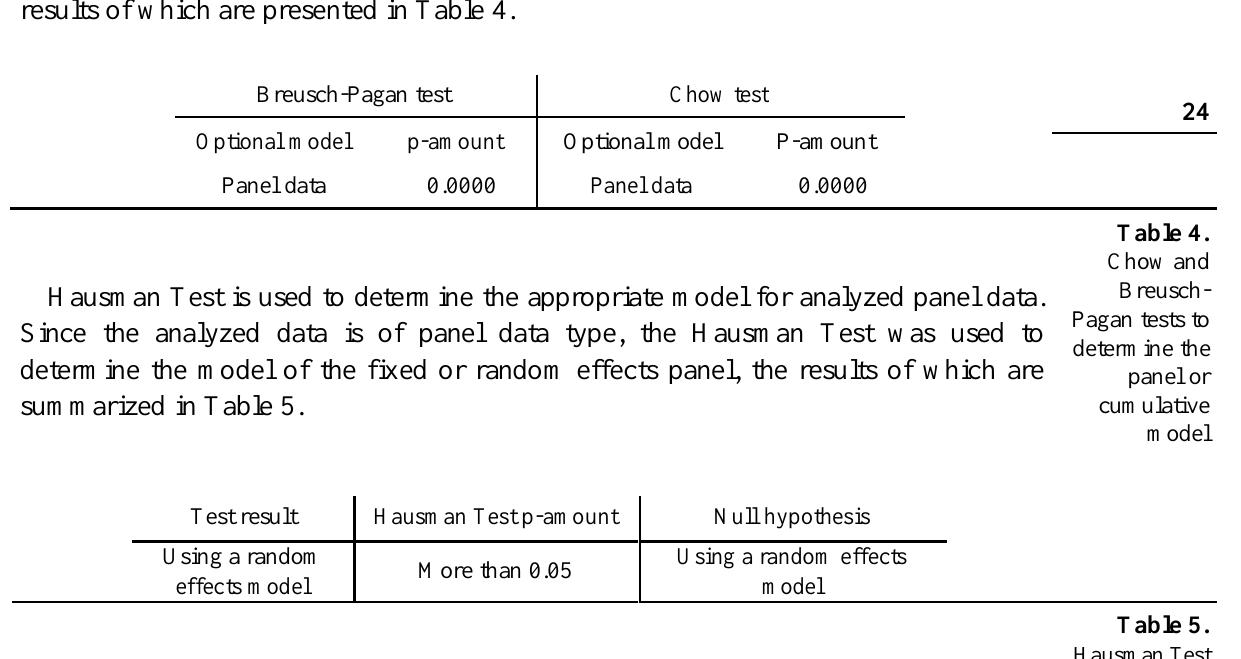
Hausman Test to determine fixed